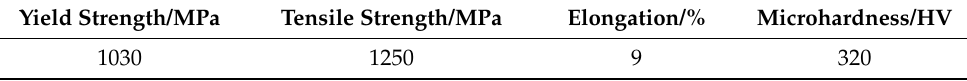
Table 1. Chemical composition of the test steel. Table 2. Mechanical properties of the test